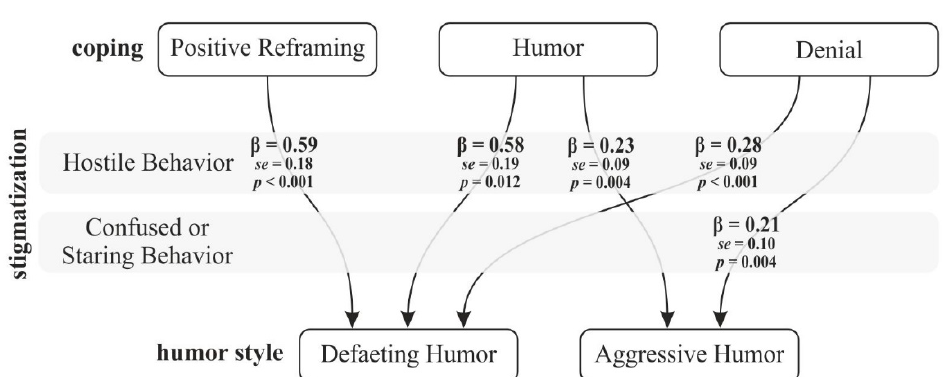
Figure 1. Perceived stigma as a mediator between humor style and ways of coping with group women with stress in group women with overfat.